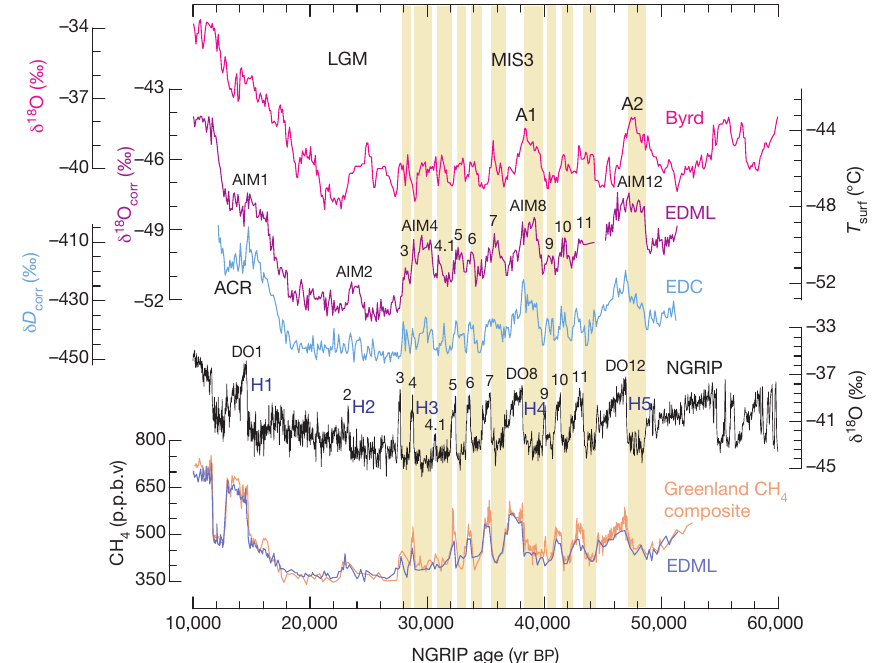
Fig. 10. Methane synchronization of the EDML and the NGRIP records reveals a one-to-one assignment of each Antarctic warming with a corresponding stadial in Greenland (adapted from EPICA Community Members,